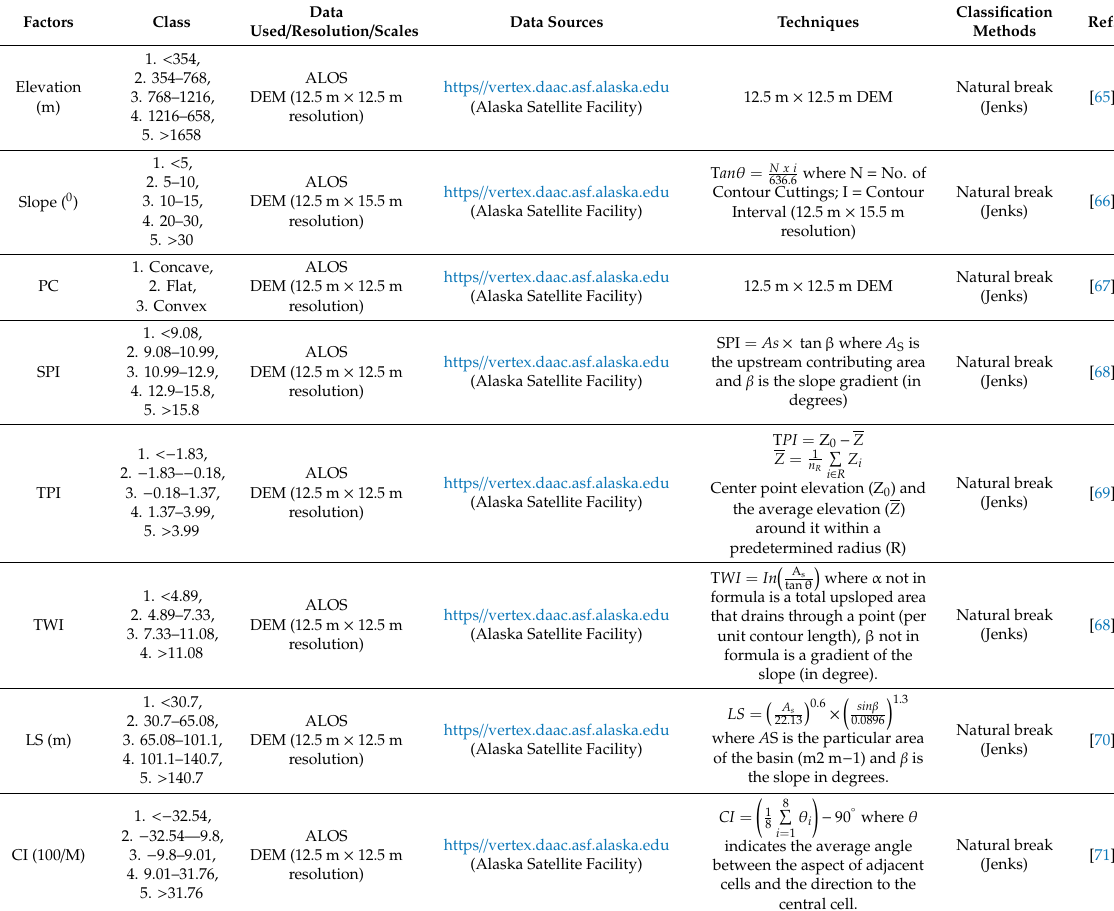
https // vertex.daac.asf.alaska.edu (Alaska Satellite Facility)